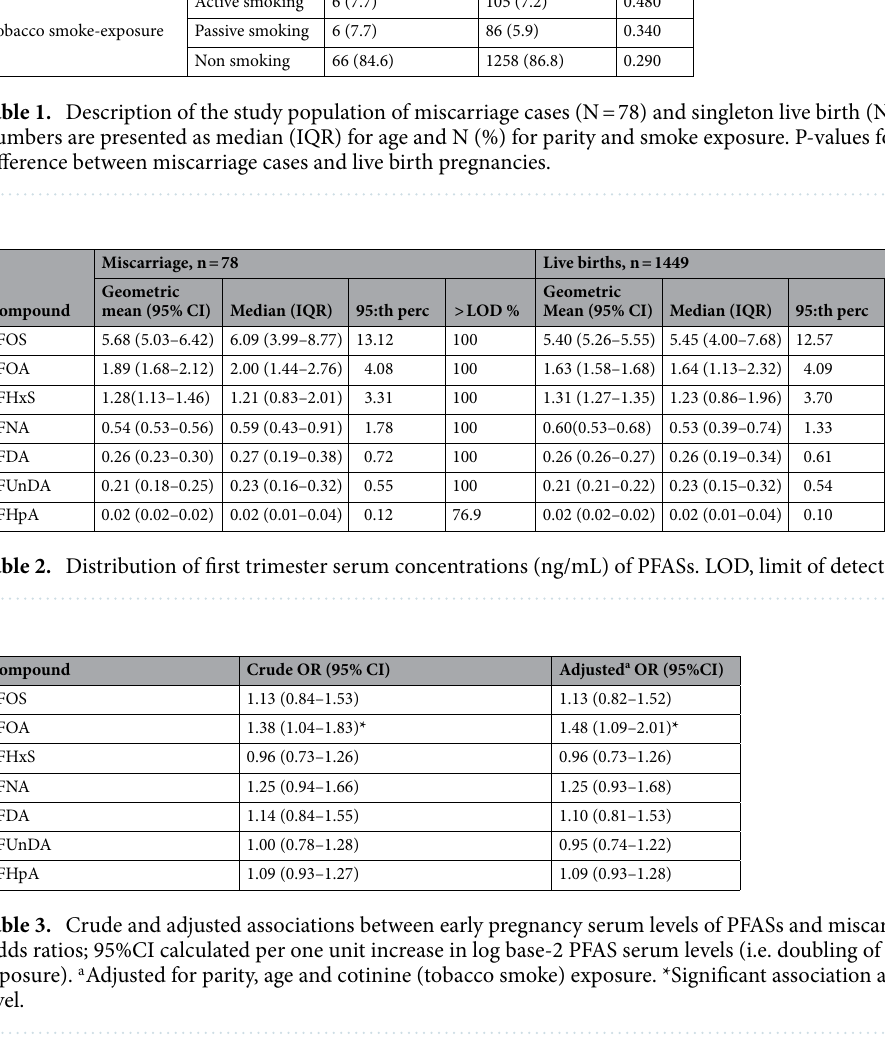
Table 3. Crude and adjusted associations between early pregnancy serum levels of PFASs and miscarriage. Odds ratios; 95%CI calculated per one unit increase in log base-2 PFAS serum levels (i.e. doubling of exposure). a Adjusted for parity, age and cotinine (tobacco smoke) exposure. *Significant association at p < 0.05